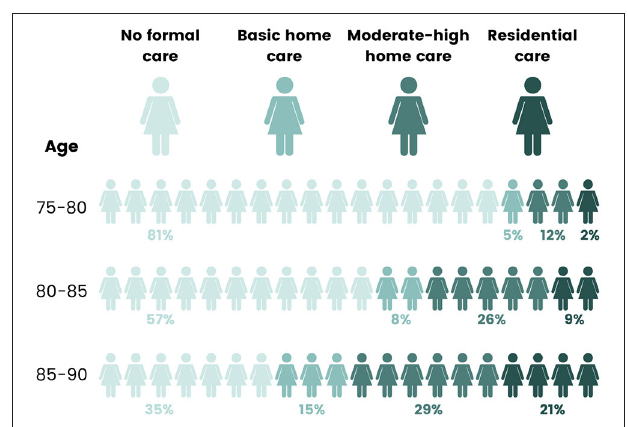
FIGURE 3 | Use of aged care services by women as they aged from 75–80 years (2001) to 85–90 years (2011). Adapted from Rahman et al. ( 27), with permission from